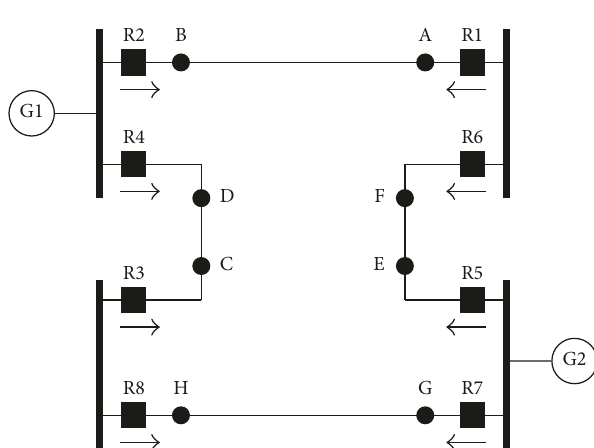
Figure 16: IEEE 4-bus DOCRs coordination problem